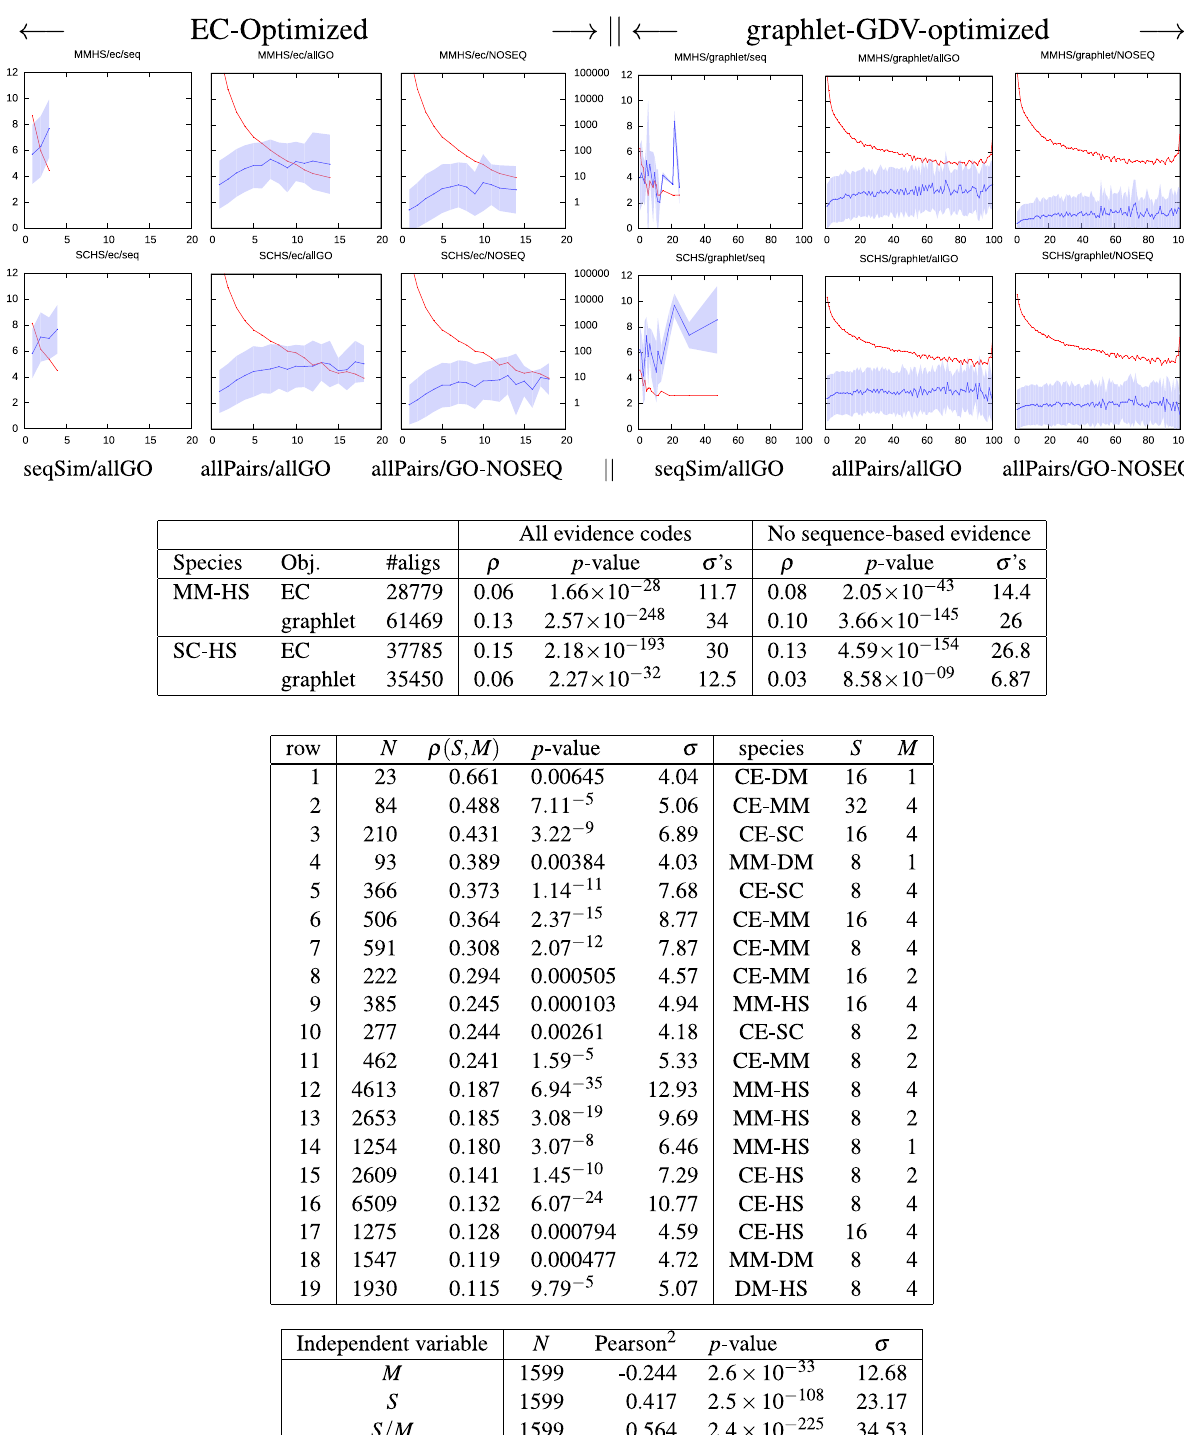
Fig. 2 Two rows of fi gures at top plot the Resnik-based similarity vs. NAF between mouse-human (top row) and yeast-human (bottom row). Top Table: Pearson correlation ( ρ ) and statistical signi fi cance of the plots. Middle Table: Filtering for well-annotated proteins, we see higher Pearson correlations between NAF and Resnik score (allowing all evidence codes) that result when fi ltering for well-annotated protein pairs in EC-driven alignments; N is the number of aligned protein pairs for which both proteins are annotated with at least S GO terms that are each annotate at most M proteins per species. We exhaustively list every pair of BioGRID species for which the Pearson p -value is <10 − 2 for S ≥ 8 and M ≤ 4; the table is sorted by ρ ( S , M ). Bottom Table: Pearson correlation between M , S , and ρ ( S , M ) above, across all species and values M and S for which ρ ( S , M ) was statistically signi fi cant (see text for further